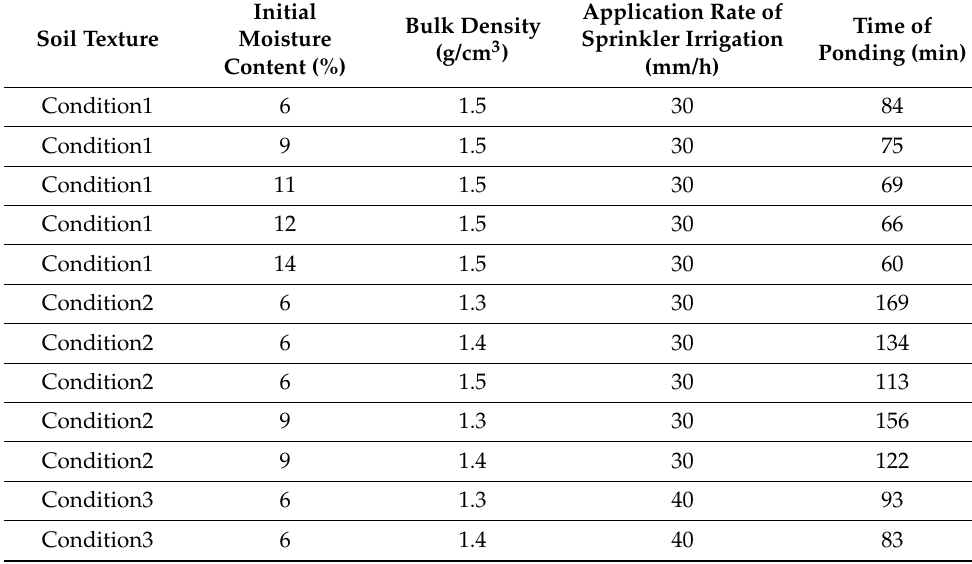
Table 3. Partial simulation